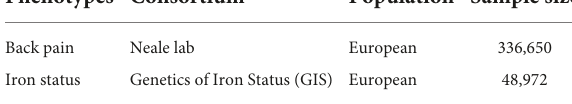
biomarkers. The details of included GWAS are shown in TABLE 1 Details of GWAS